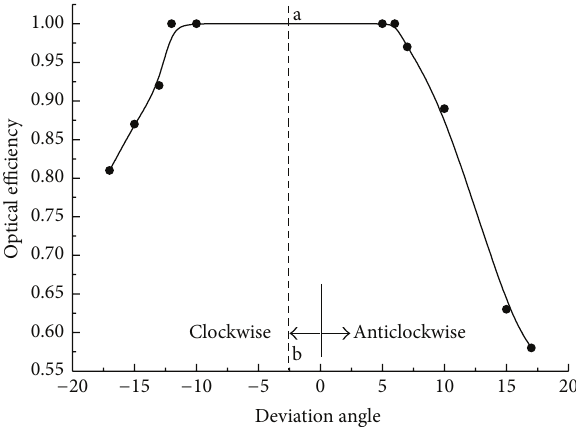
Figure 5: The relationship between the ideal optical efficiency and deviation angle of the